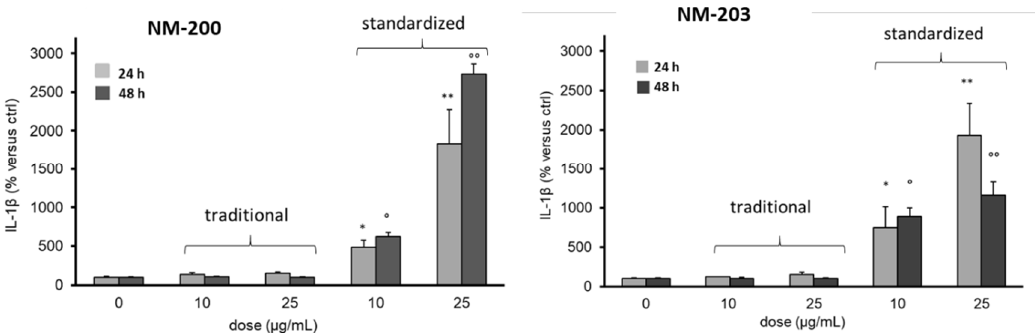
Figure 10. E ff ect of the dispersion protocols on extracellular levels of Interleukin-1 β (IL-1 β ) in THP-1 cell cultures by NM-200 and NM-203. Cells were incubated for 24–48 h in the absence (0, control) or presence of NM-200 and NM-203 at a concentration of 10 and 25 µg/mL. The results are expressed as percentage increase of IL-1 β vs. the respective control incubated without NM-200 or NM-203 (assumed as 100%). Each measurement was performed in duplicate, and data are presented as means ± SEMs (n = 3 readings): * p < 0.01; ** p < 0.0001; ° p < 0.005 °° p < 0.0001.